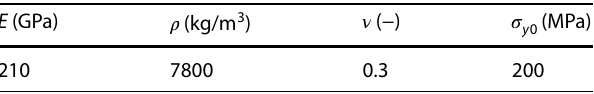
E refers to Young’s modulus and 𝜌 , 𝜈 , and 𝜎 y 0 refer to density, Pois- son’s ratio and initial yield stress, respectively